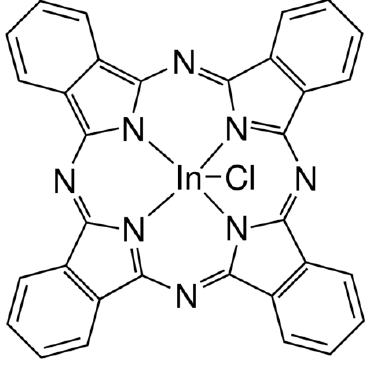
Figure 1. Structure of the InClPc.